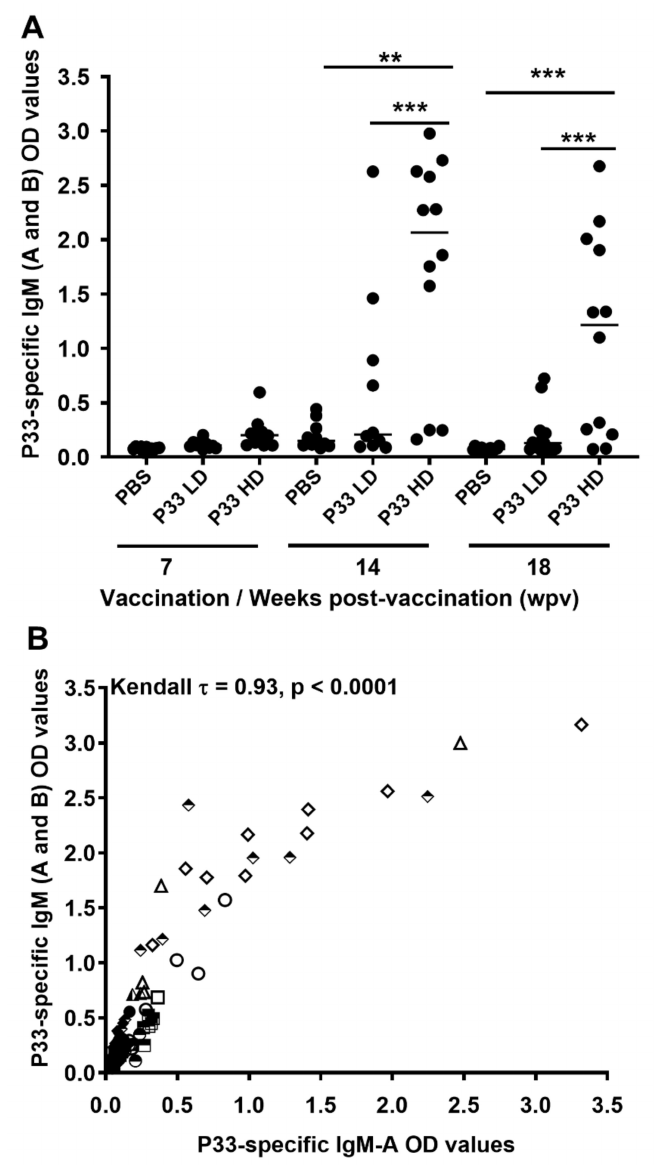
Figure 3. P33 vaccination induces specific antibody response in the plasma of vaccinated fish. ( A ) Column scatter plot of ELISA OD values representing P33-specific IgM Ab (A and B subtypes) in plasma of mock-vaccinated (injected with phosphate-buffered saline [PBS]) or P33-vaccinated (low-dose [LD] consisted of 0.1 mg/mL P33 orhigh-dose [HD] with 0.5 mg/mL P33) groups, at 7-, 14-, and 18-weeks post-vaccination (wpv). Horizontal lines on the plot represent the median OD values in different groups. Asterisks denote significant differences (** p < 0.01; *** p < 0.001). ( B ) Scatter plot of levels of P33-specific IgM subtype A antibody (OD values; x -axis) versus levels of P33-specific IgM antibody subtype A and B (OD values; y -axis) showing the correlation between P33-specific IgM-A and IgM (A and B subtypes) ELISA OD values in plasma of P33-vaccinated (LD and HD) and mock-vaccinated (PBS and M. viscosa ) fish collected at 7 (solid symbols), 14 (open symbols) and 18 (half-open symbols) wpv.Kendall’s rank correlation coefficient ( τ ) and p -value are